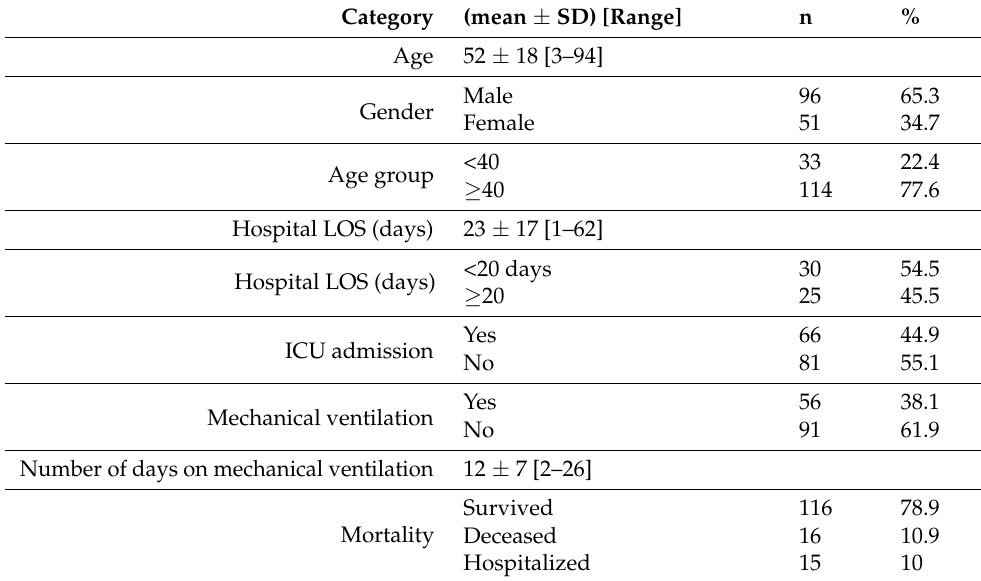
Table 1. Sociodemographic patient data and clinical outcome measures.